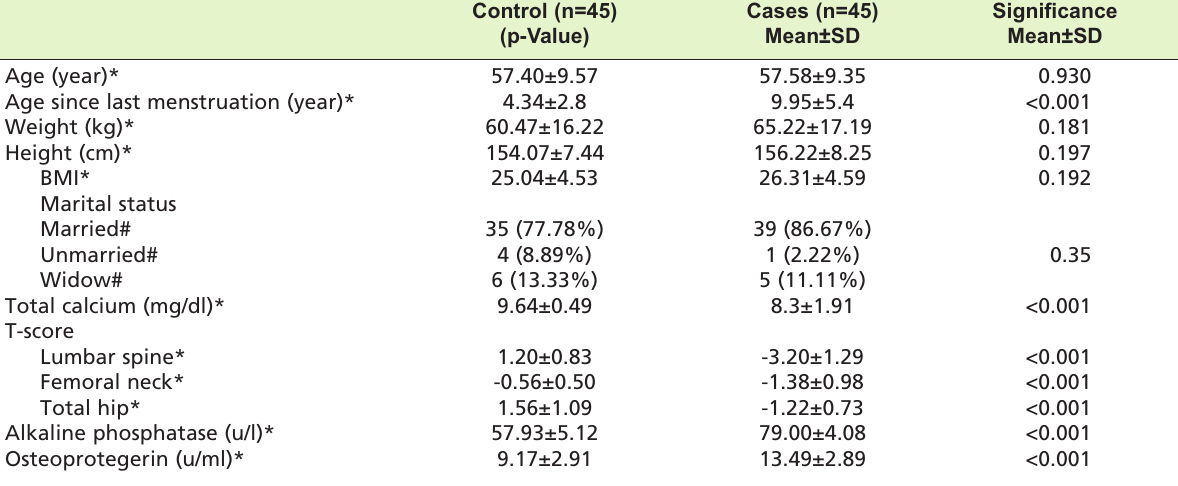
Shows distribution of different parameters in cases and control group Table I: Control (n=45)